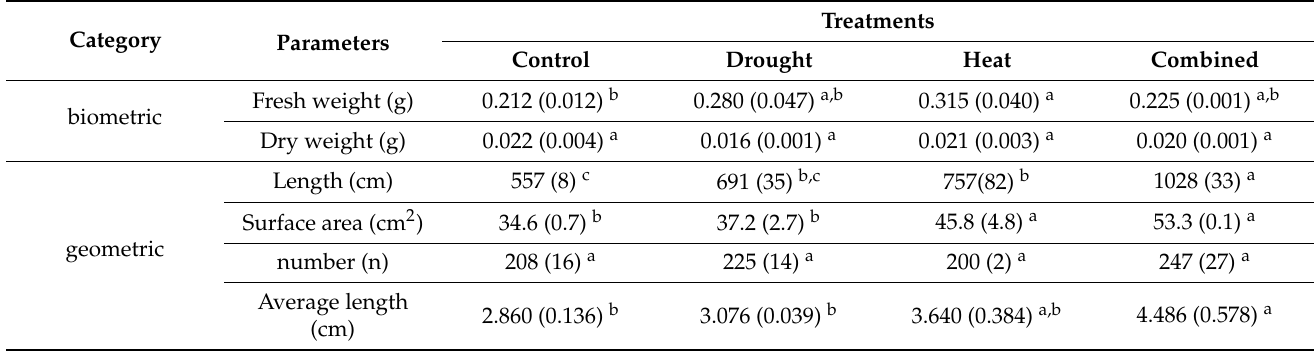
Table 3. Morphology of primary lateral root of maize plants exposed to single (drought and heat) and combined stress (drought +